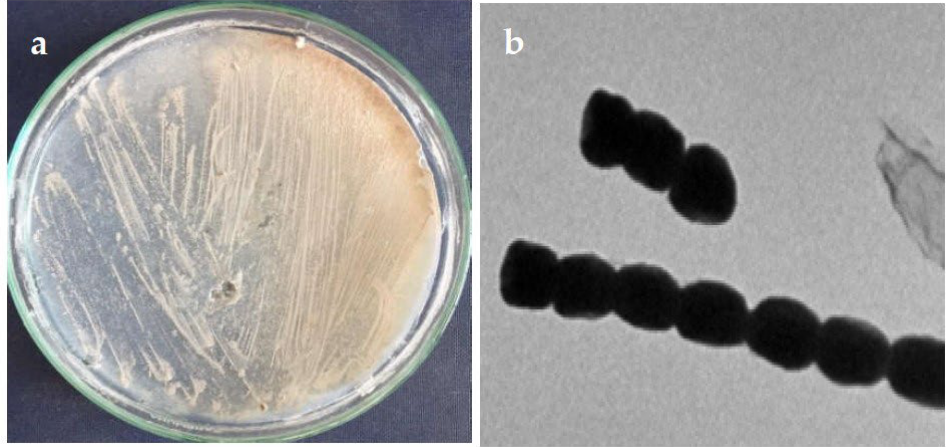
Figure 1. ( a ) Aerial and substrate mycelium morphology; ( b ) spore chain morphology under trans- mission electron micrography.